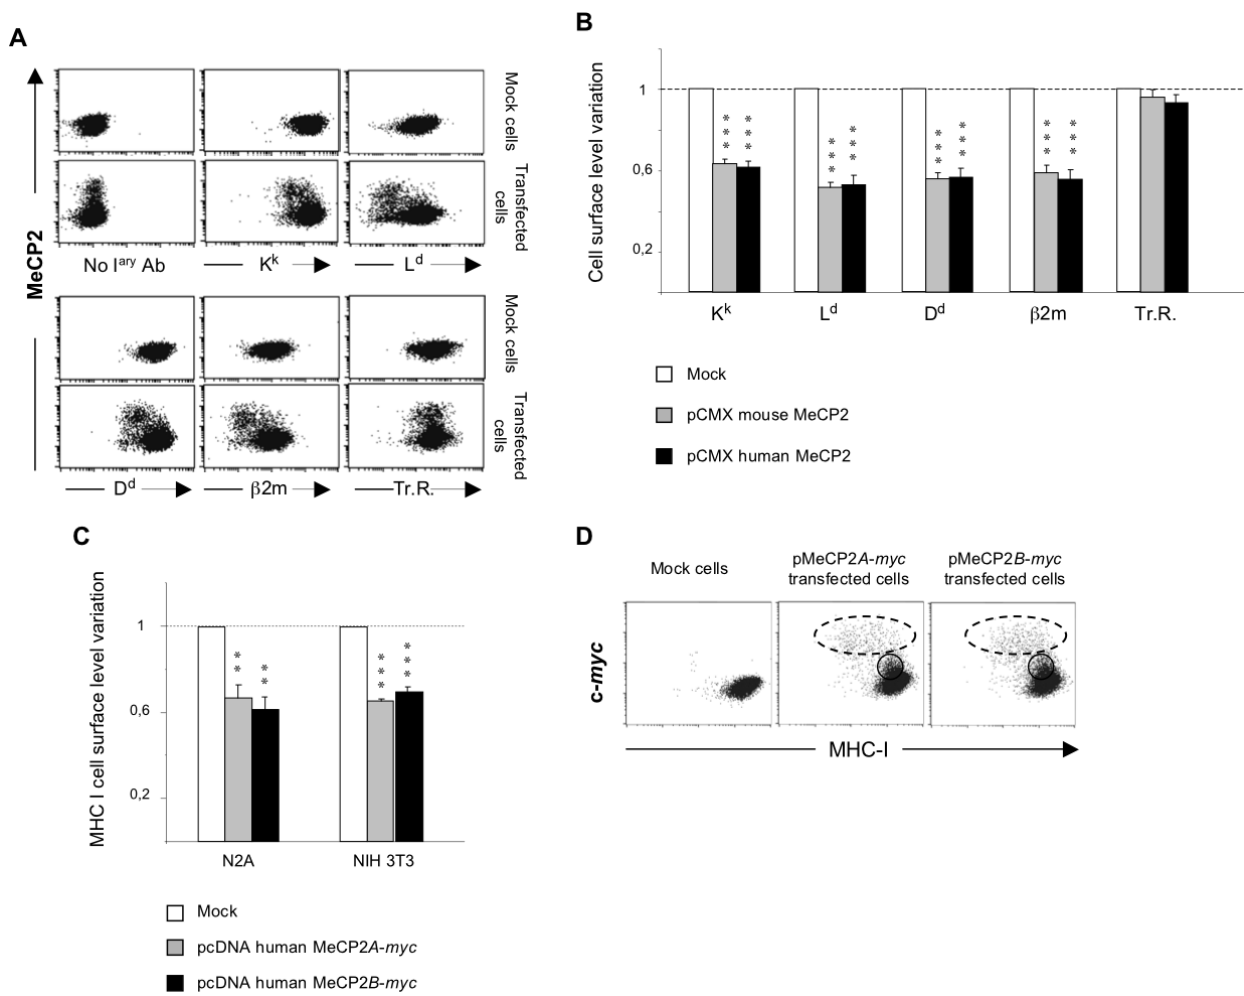
Figure 1. MeCP2 overexpression diminishes MHC class I expression. N2A cells transfected with pCMX vectors expressing either murine or human MeCP2 were immunostained for one of the three MHC class I molecules (K k , L d or D d ), b 2-microglobulin or the transferrin receptor on the cell surface as well as for intracellular MeCP2. The level of staining was then analysed by fluorescence-activated cell sorting. Panel A: Dot plots of the amount of surface antigen (x-axis) against the amount of intracellular MeCP2 (y-axis) in cells transiently transfected with pCMX expressing human MeCP2 and analysed 48 hrs later. Panel B: For each kind of staining, the variation in expression level was calculated as the ratio of MFI of MeCP2 overexpressing cells over MFI of mock-transfected cells. The histograms summarise the mean ( 6 SEM) of the variation in cell surface levels from 15 independent transfections with vectors expressing mouse MeCP2 A (grey fill) and 12 independent transfections with vectors expressing human MeCP2 A (black fill). Panel C: N2A and NIH3T3 cells were transfected with empty pcDNA3.1( + ) (mock cells) or expressing Myc-tagged human MeCP2 A or B isoforms. 48 h after transfection, cells were subjected to double staining against cell surface MHC class I molecules and intracellular Myc-tagged MeCP2, then analyzed by flow cytometry. The variation in expression level of MHC class I molecules was calculated as the ratio of MFI of MeCP2 over-expressing cells over the MFI of mock cells. The histograms represent the mean ( 6 SEM) of the cell surface level variation from 4 independent transfections with each of the vectors. Panel D: A representative example of dot-plots obtained for double immunostaining of transiently transfected N2A cells with anti-Myc 9E10 and rat-anti-mouse-MHC I M1/42 monoclonal antibodies. Dotted and continuous circles indicate the different populations expressing high and intermediate levels of MeCP2, respectively. Statistical significance of difference between groups was analysed by using an unpaired t-test (**, p , 0.01 ; ***, p , 0.001).